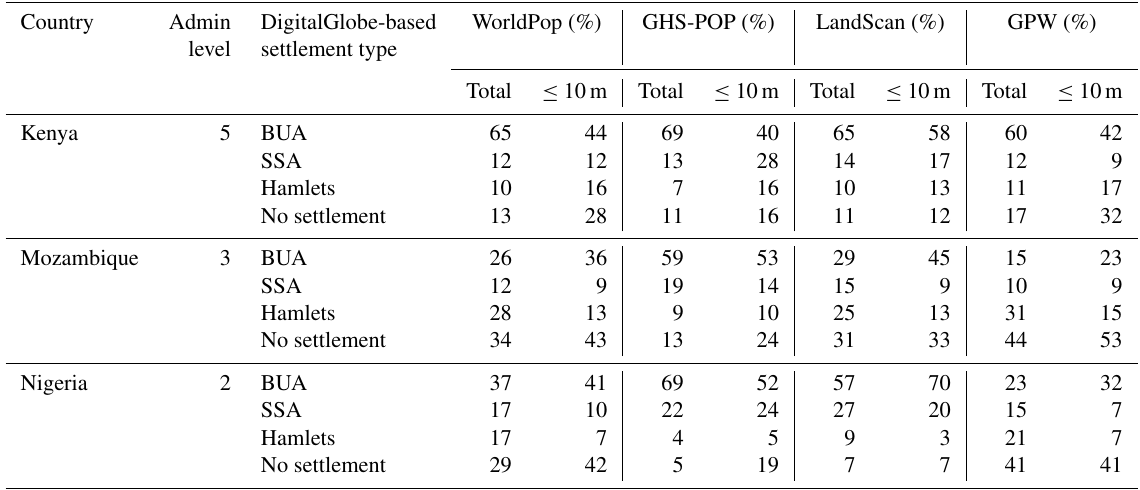
Table C1. Comparison of population data sources by level of input unit in GPW, by urban–rural classes and urban-proxy data sets, in the LECZ.